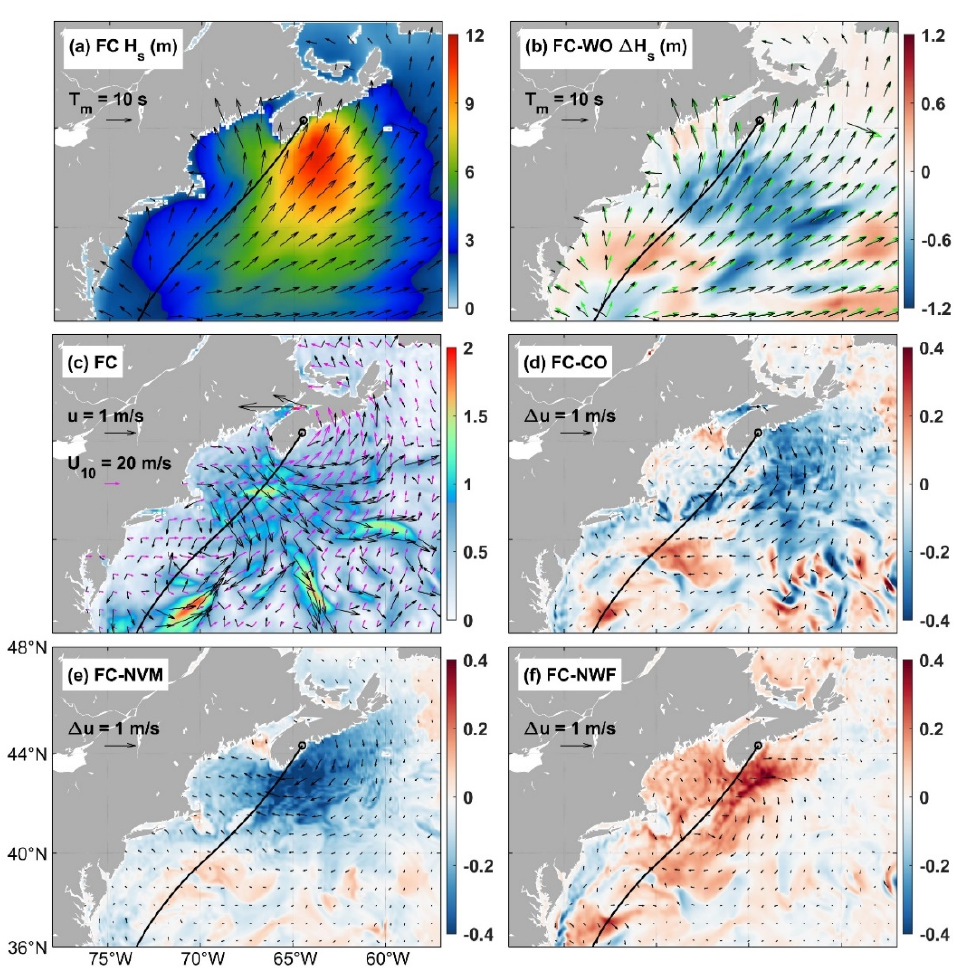
Figure 14. Distributions of ( a ) SWHs (color) and ( c ) surface currents (color) in run FC at 1500 UTC 4 September. Mean wave directions (arrow) and periods (length of the arrow) are also shown in ( a ). Surface current vectors (black arrow) and wind vectors (magenta arrow) are also shown in ( c ). ( b ) Changes in SWHs (color) and mean wave directions between runs FC (black arrow) and WO (green arrow). ( d – f ) Changes in surface currents between different model runs.